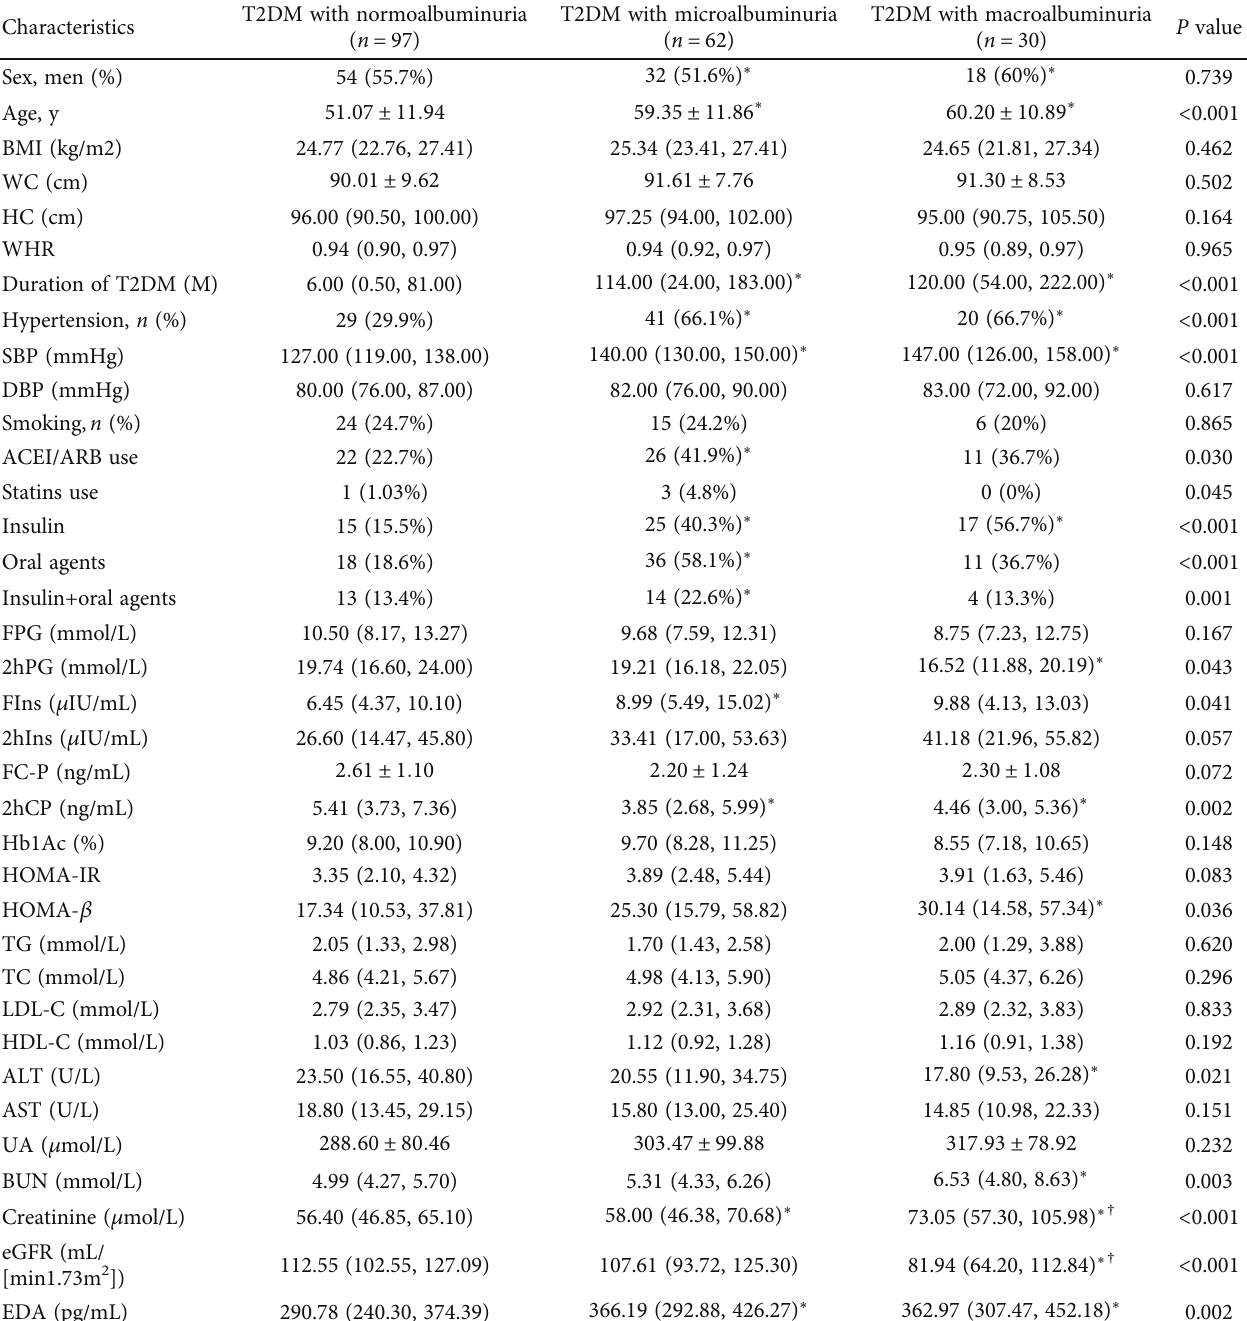
Table 2: Baseline clinical characteristics between all subgroups of